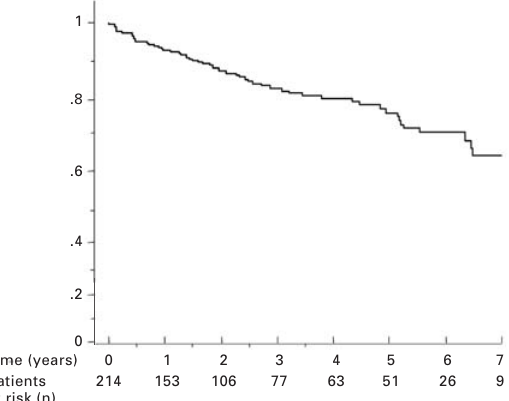
Figure 1 Kaplan-Meier esti- mates of survival free of inappropriate defibrillator inter-